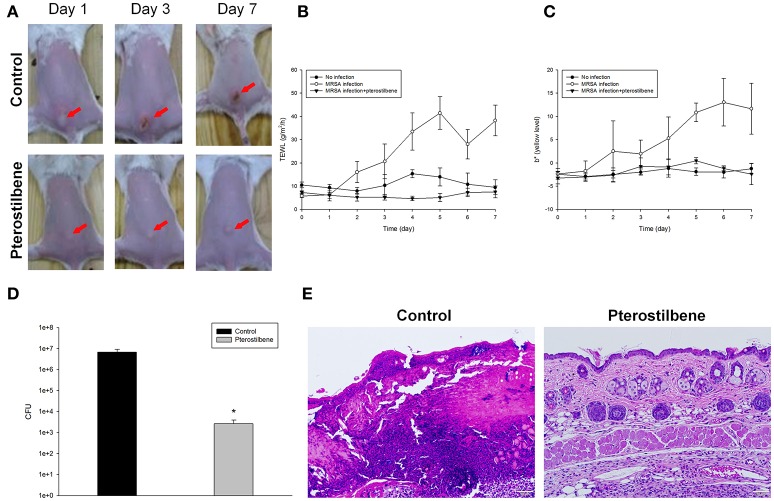
In vivo topical application of pterostilbene against MRSA: (A) The skin surface of mice after treatment of MRSA at day 1, 3, and 7; (B) Transepidermal water loss (TEWL) of mice skin treated with MRSA; (C) Yellow/blue color (b*) of mice skin treated with MRSA; (D) Survival of MRSA in mice skin treated with MRSA. Seven days after infection, skin lesions were cut, homogenized, and bacterial count was determined by CFU assay, and (E) Histological observation of mice skin biopsy after treatment of MRSA. On day 7, biopsy specimens were taken immediately after the termination of the experiment and stained with hematoxylin and eosin (H&E). Scale bar = 50 μm. Each value represents the mean and S.D. (n = 6).